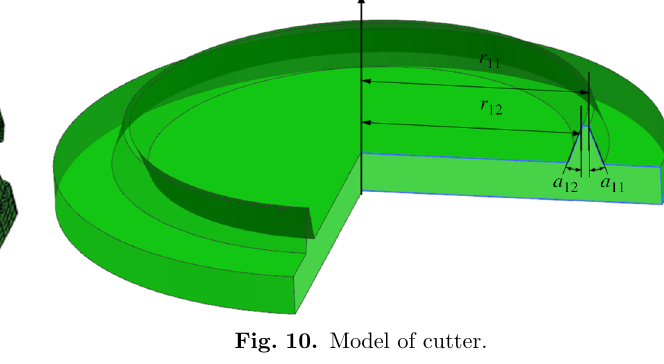
Fig. 10. Model of cutter.